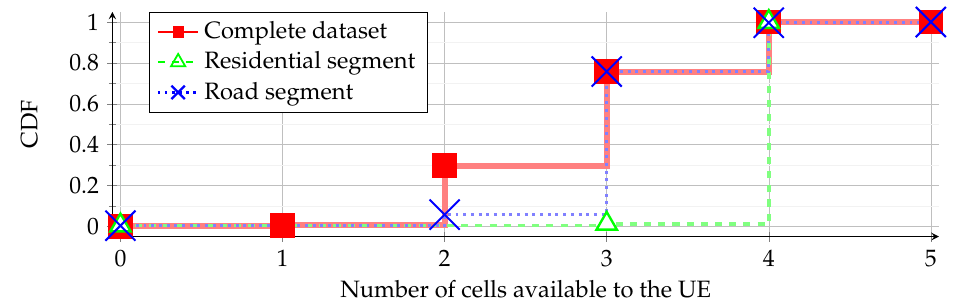
Figure 2. Cumulative distribution of available